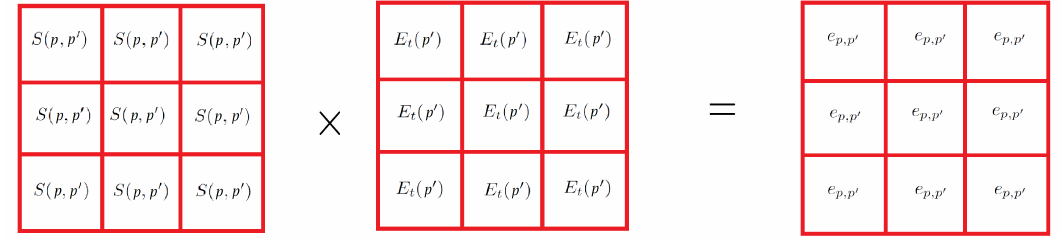
Figure 9. Spatial fusion: weight of initial fuzzy